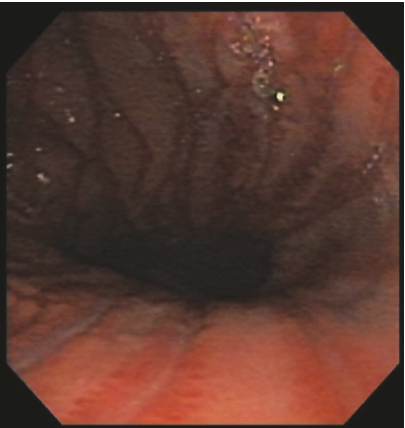
Figure 4: Linear erythema of gastric body and fundus.